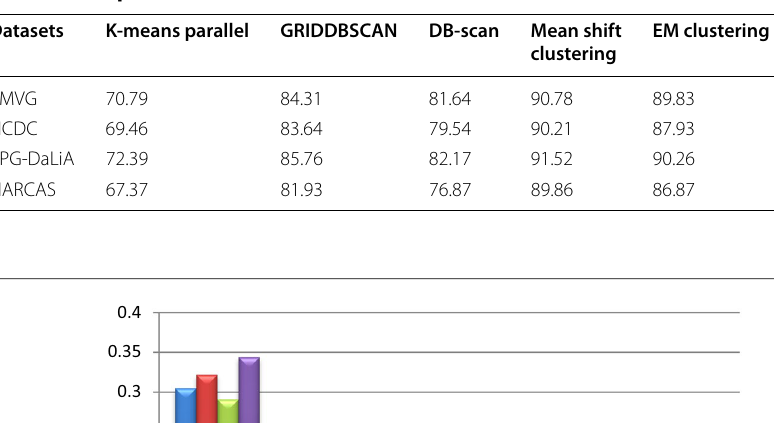
Table 5 Comparison of Rand Index